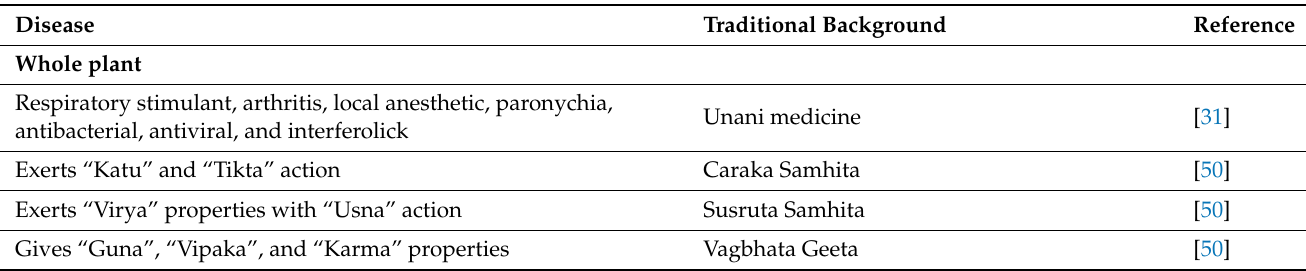
Table 1. Traditional uses of E. neriifolia